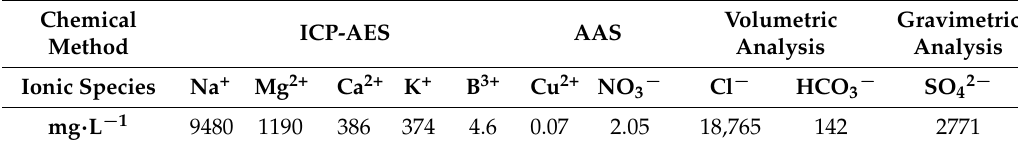
Table 2. Composition of seawater obtained from San Jorge Bay, Antofagasta,